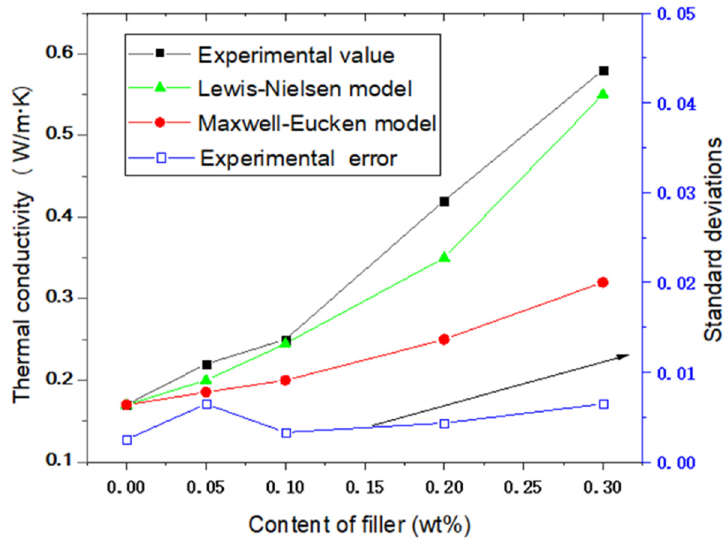
Figure 6. Thermal conductivities of SR and h-BN/SR composite.